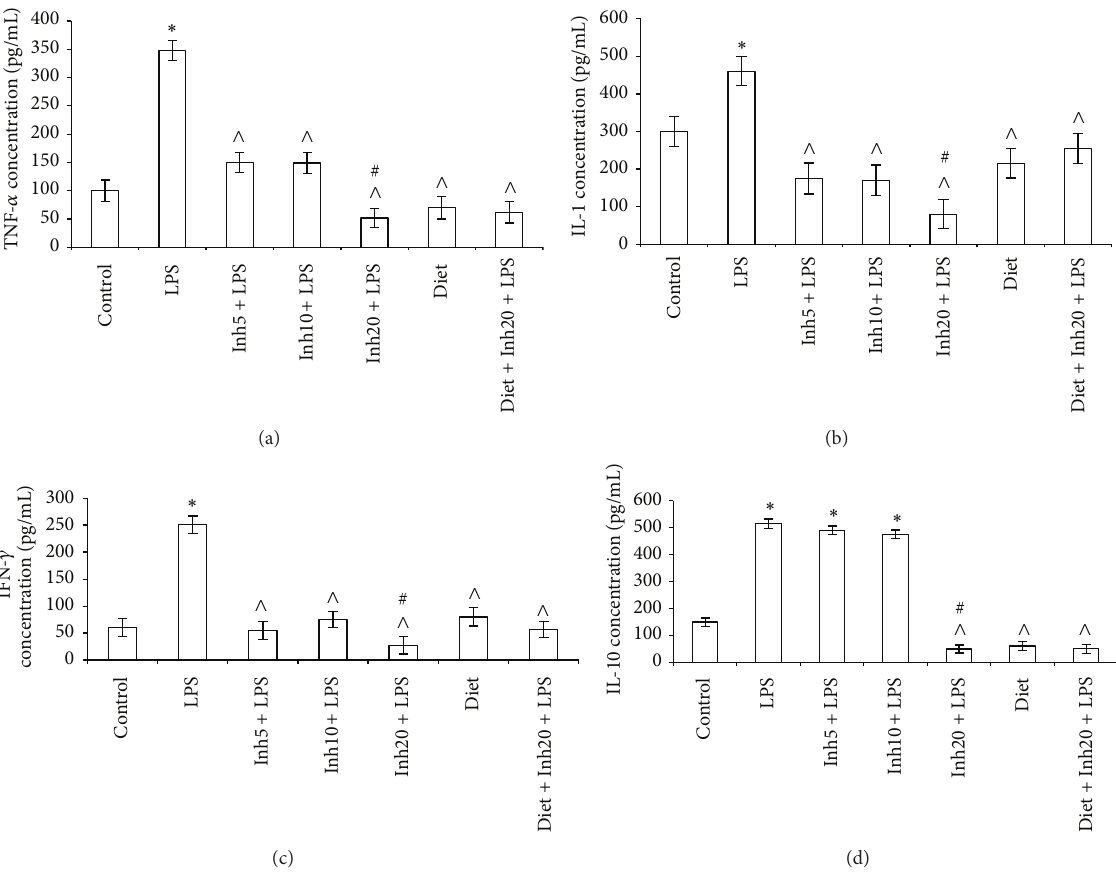
Figure1:Plasmacytokinevaluesininflammation-bearingmicetreatedwithantioxidant-richdietandIKKInhibitorXII.Sevenmousegroups were used: inflammation-bearing (IB) mice; three groups of IB mice pretreated with inhibitor at concentration 5 mg/kg (Inh5), 10 mg/kg (Inh10), or 20 (Inh20) mg/kg; IB mice pretreated with antioxidant-rich diet; IB mice pretreated with antioxidant-rich diet plus inhibitor; and untreated controls. Each group consisted of 4 mice, which was examined individually. Each value is average mean ± SD from four independent experiments; the measurements were made for each individual mouse in six duplicates. Data are expressed in pg/mL of plasma. ∗ Significantly different from control, 𝑃 < 0.05 . ∧ Significantly different from LPS-group, 𝑃 < 0.05 . # Significantly different from Inh(5) or Inh (10) plus LPS- group, 𝑃 < 0.05